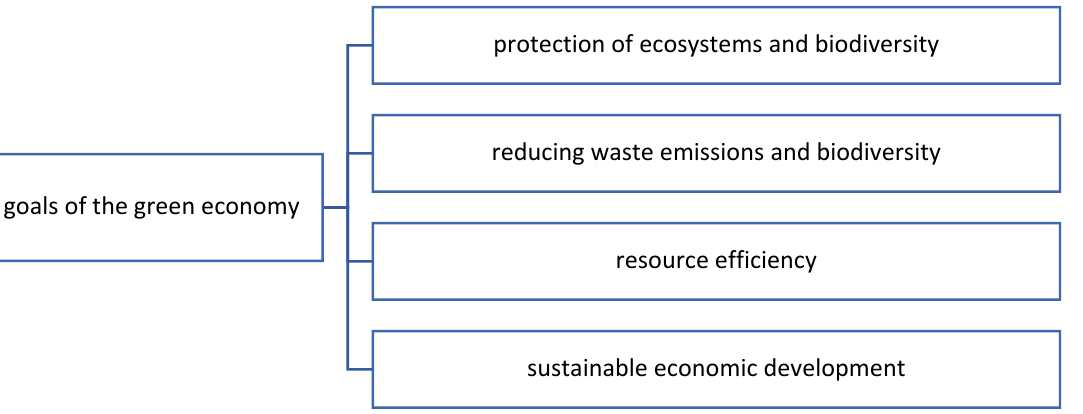
Figure 1. Goals of the green economy. Source: study based on Iwona B ą k, Katarzyna Cheba, Zielona gospodarka jako narz ę dzie zrównowa ż onego rozwoju, wyd. CEDEWU 2020; Marcin Rabe, Zielona gospodarka jako narz ę dzie zrównowa ż onego rozwoju, Studia i Prace Wydzia ł u Nauk Ekonomicznych i Zarz ˛adzania 46/2, 117–124,